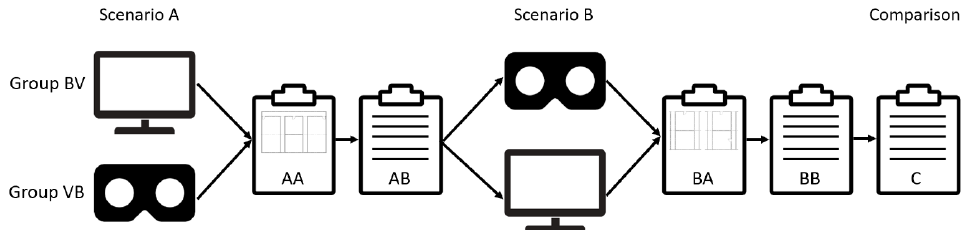
Figure 7. Experiment B—Synchronous Collaboration’s procedure.